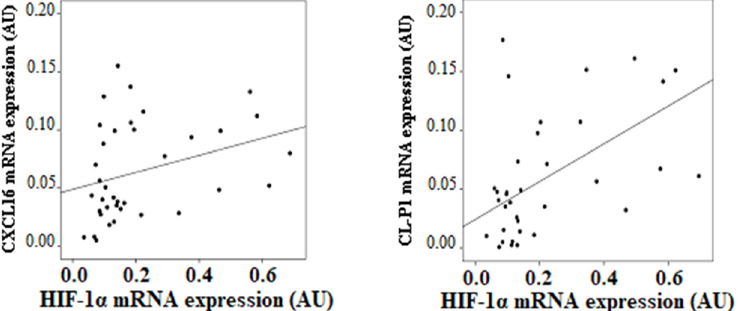
Figure 4. Significant correlations found in visceral mature adipocytes between the mRNA expression of HIF-1 α and scavenger receptors.